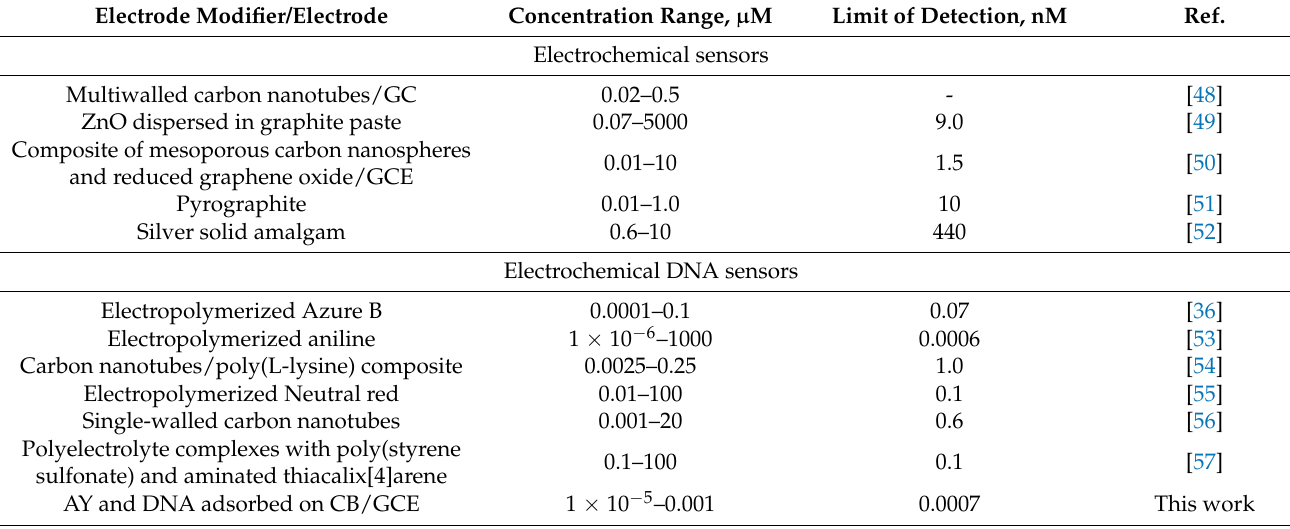
Electropolymerized Azure